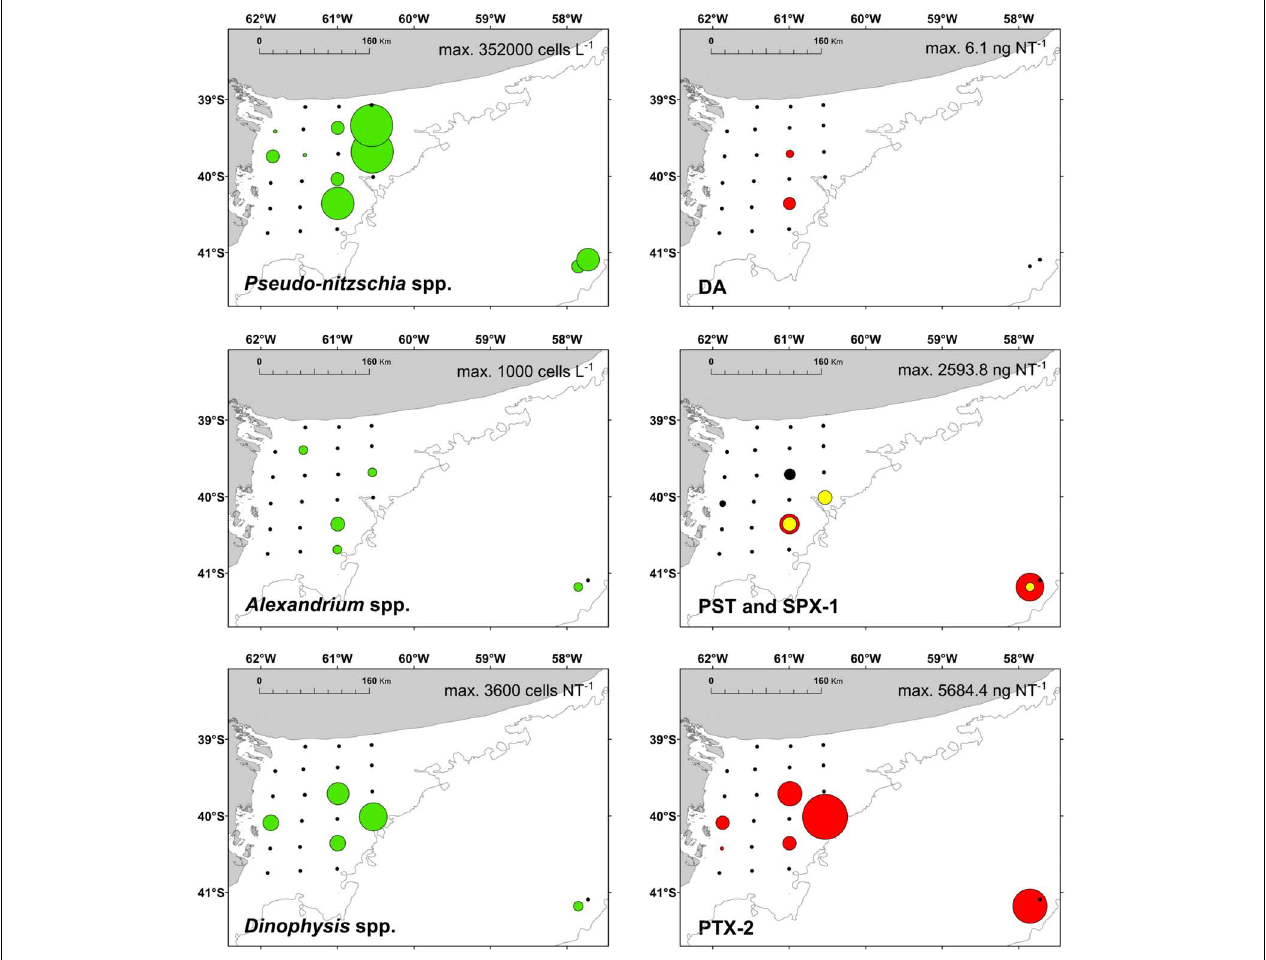
FIGURE 6 | Left panels: distribution of the potential toxigenic diatom Pseudo-nitzschia spp. and the dinoflagellate Alexandrium spp; and the ciliate Mesodinium rubrum (prey of Dinophysis spp.) (green); right panels: distribution of the respective phycotoxins in September 2015 (red). DA, domoic acid; PST, paralytic shellfish toxins; SPX-1, 13-desmethyl spirolide C (yellow); and PTX-2, pectenotoxin-2 (produced by Dinophysis